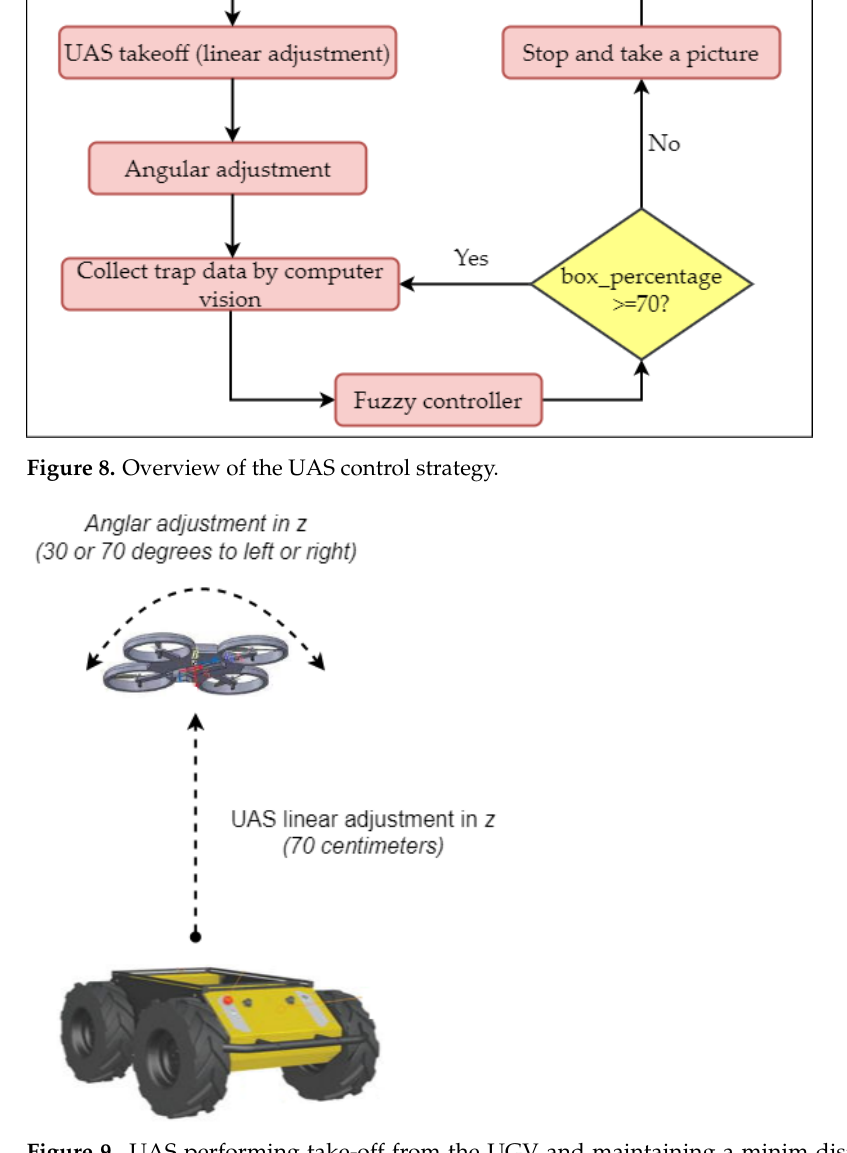
Figure 9. UAS performing take-off from the UGV and maintaining a minim distance. After the z _ linear adjustment, the UAS performs a z _ angular adjustment according to the trap’s